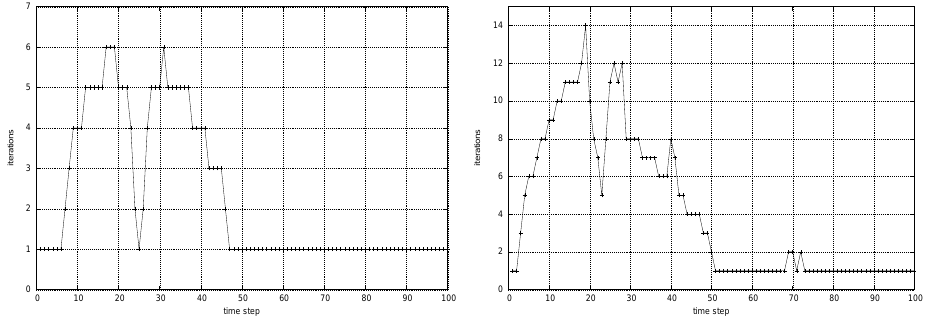
Figure 6. Time history of iterations number to obtain the convergence at each time step for V max = 10 ( left ) and V max = 50 ( right ).